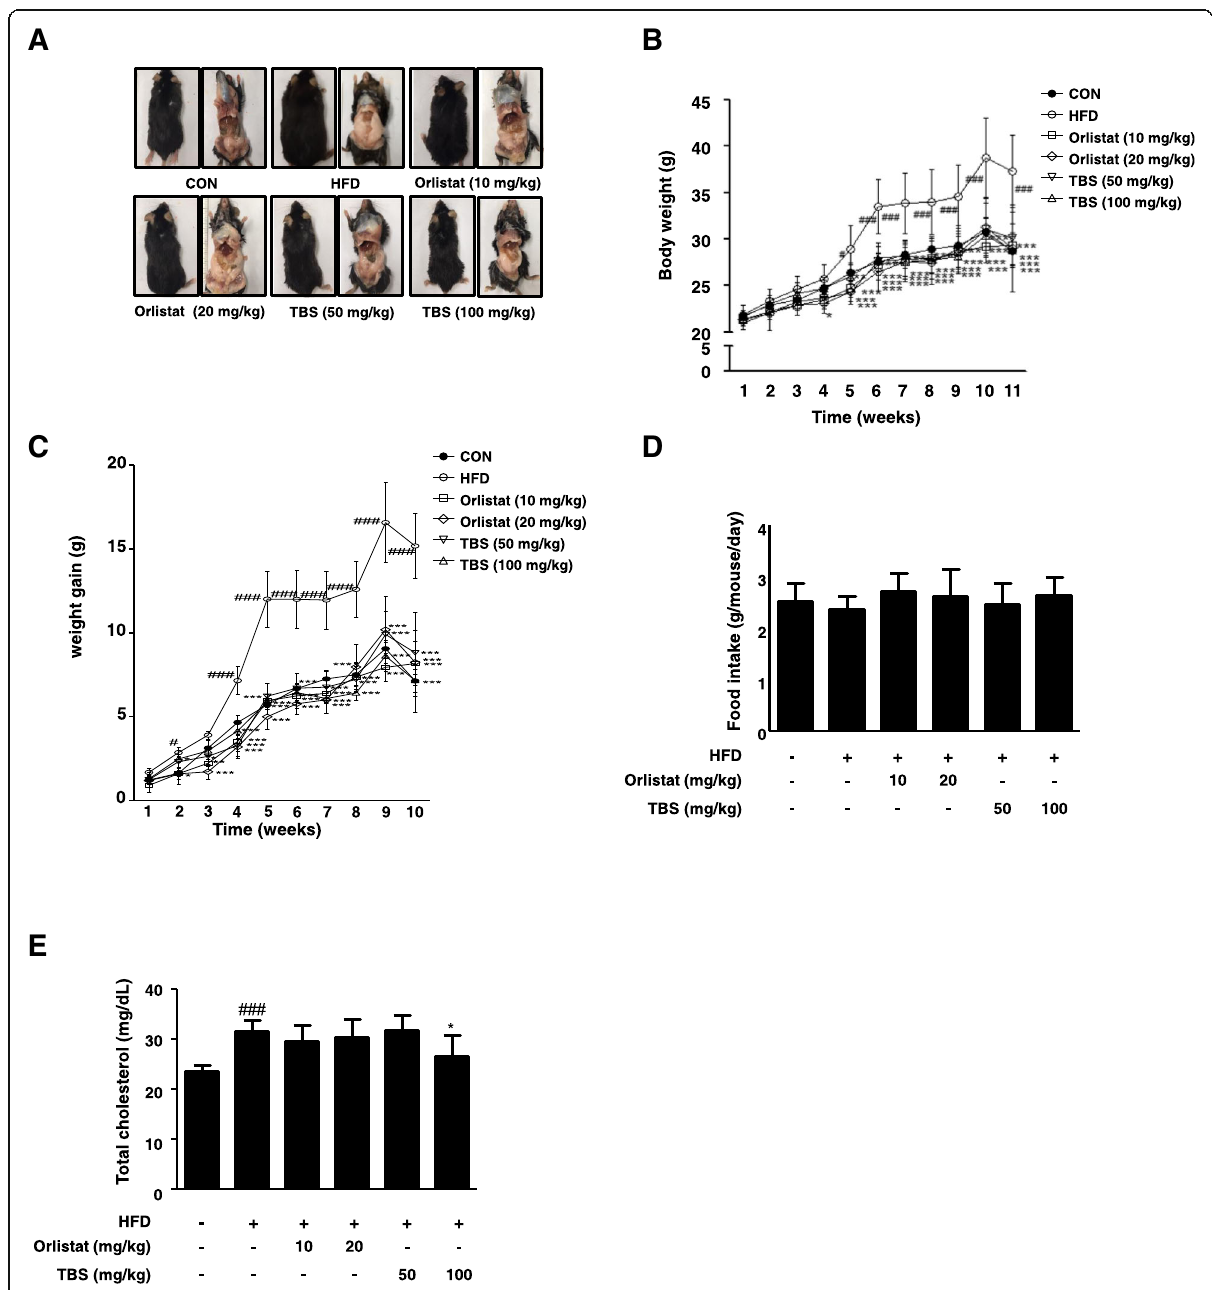
Fig. 1 Effect of TBS on adipose tissue size and body weight in high-fat diet-induced obesity in C57BL/6 N mice. ( a ) Macroscopic mouse body and WAT size analysis. ( b ) Body weight and ( c ) body weight gain were assessed every week. ( d ) Food intake was recorded two or three times per one week. ( e ) The levels of serum TC were determined using enzymatic methods. CON: normal diet group; HFD: high-fat diet group; Orlistat: HFD plus orlistat (10 or 20 mg/kg) group; TBS: HFD plus TBS (50 or 100 mg/kg) group. The values represent the mean ± S.D. # p < 0.05 and ### p < 0.001 vs. the control group; * p < 0.05, ** p < 0.01, and *** p < 0.001 vs. HFD